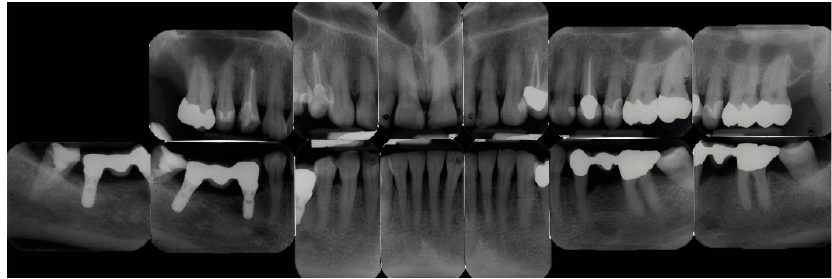
Figure 1. Full ‐ mouth intra ‐ oral radiographic set (I ‐ O) represented by periapical films.